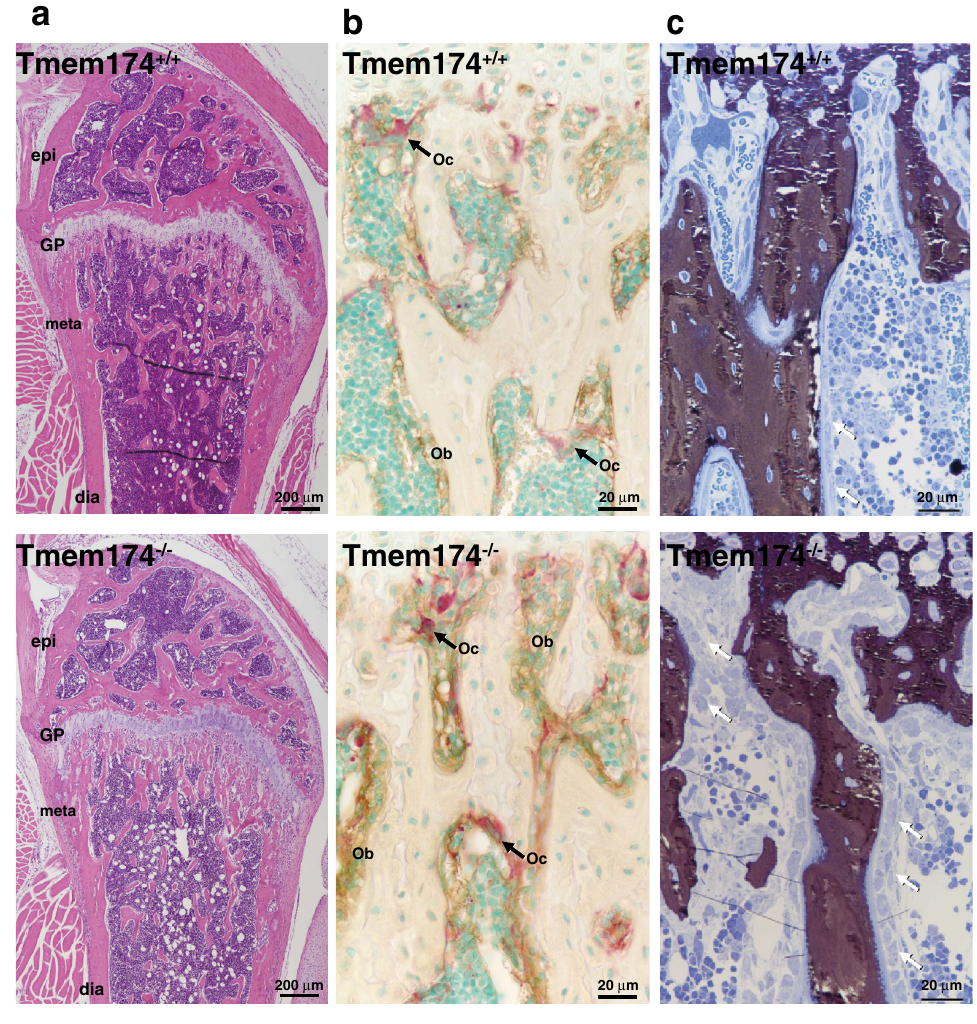
Figure 5. Bone analysis in Tmem174 −/− mice. Histological analysis of longitudinal femoral sections of 8-week- old Tmem174 +/+ and Tmem174 −/− mice. ( a ) Hematoxylin/eosin staining, ( b ) Double staining of alkaline phosphatase (brown color) and tartrate-resistant acid phosphatase (red color), ( c ) von Kossa staining of metaphyseal